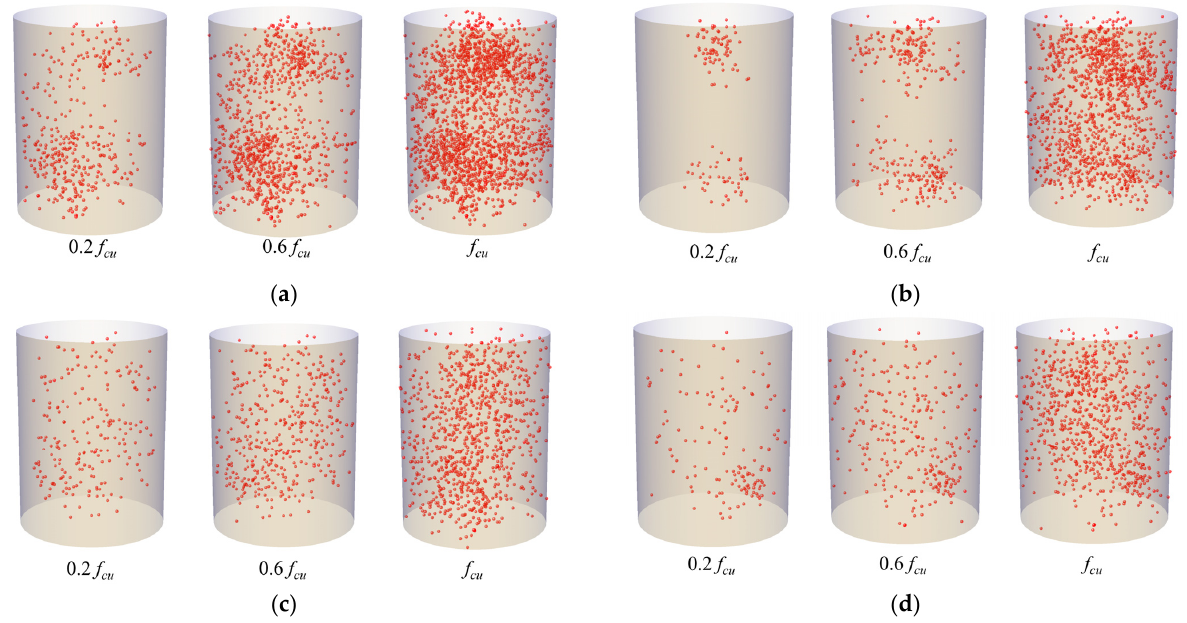
Figure 12. Spatial distribution of AE signals of each specimen under different stress levels: ( a ) URC-5, ( b ) CRC-5-2, ( c ) JRC-0-2, ( d ) JRC-5-2.